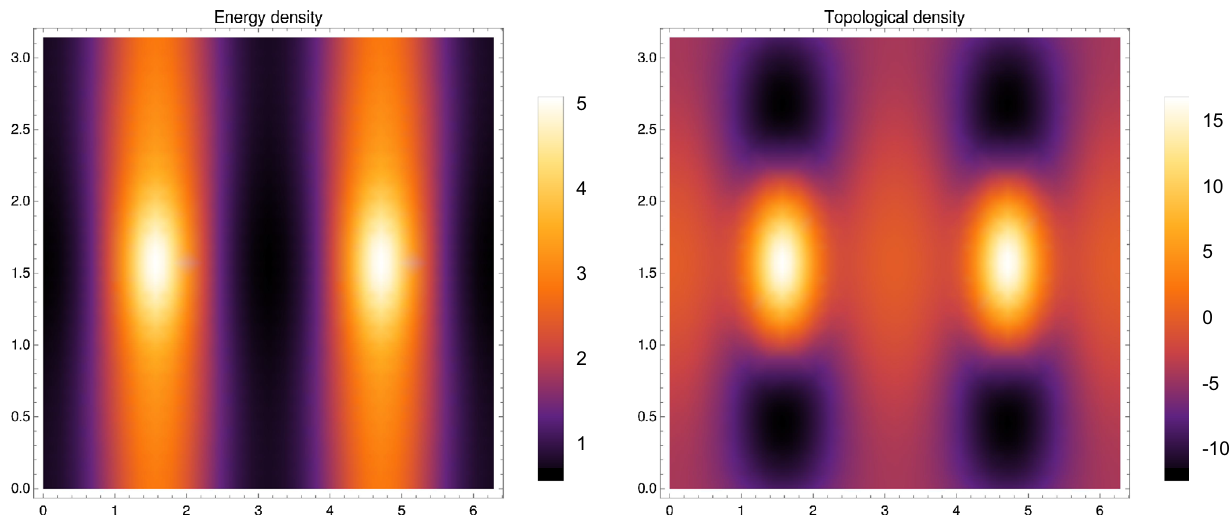
Fig. 1 Energy density and topological charge density of two gauged solitons, with n = 2, m = 0, and p = q = 1. Here we can see the periodic ordering of the tube-shaped